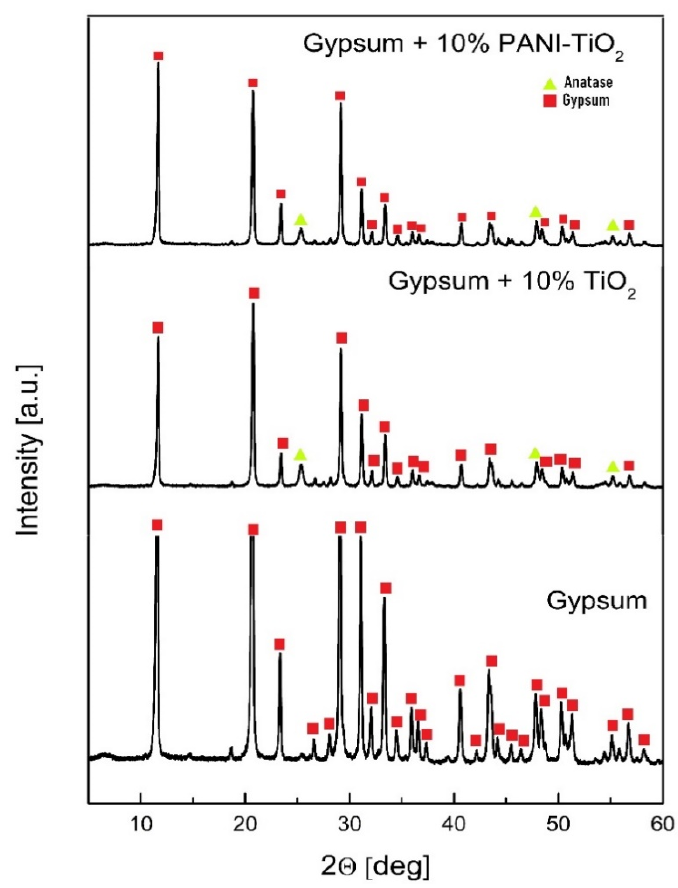
Figure 10. XRD patterns of gypsum and gypsum loaded with TiO 2 or PANI–TiO 2